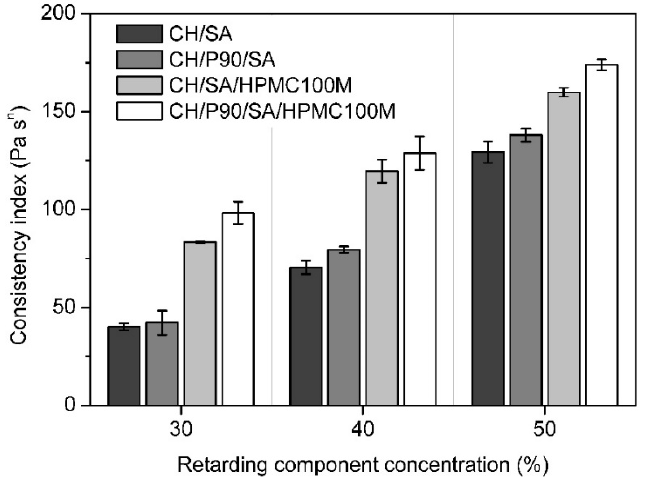
Figure 1. Consistency of the dispersions of tableting materials in PBS pH 6.8. CH − chitosan; P90 − silicificated microcrystalline cellulose Prosolv SMCC 90; SA − sodium alginate; HPMC100M − hypromellose Methocel K100M. Data are expressed as average values ± SD of three tests.